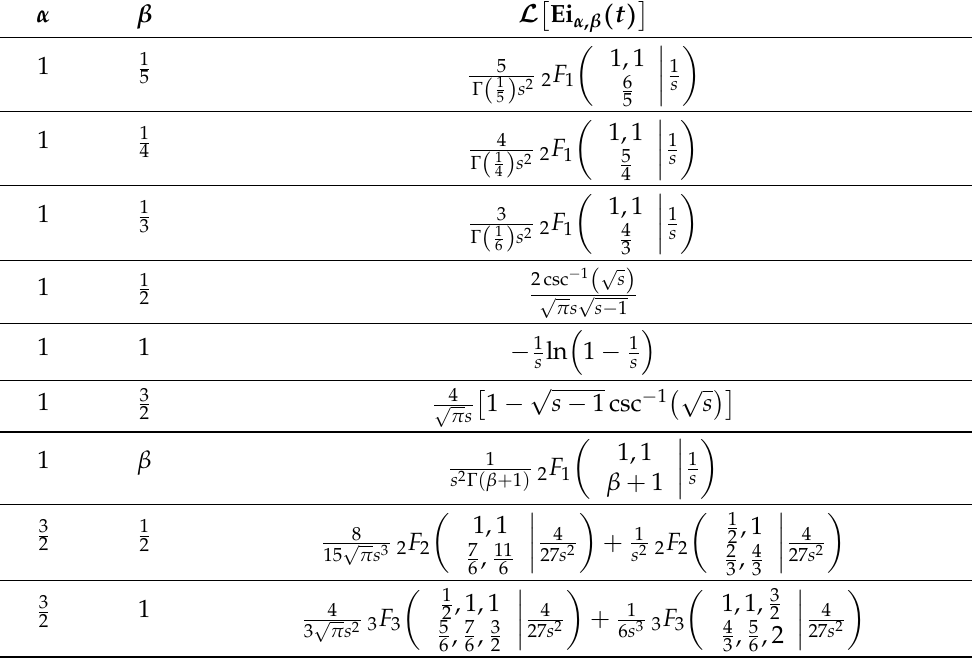
Figure 2. The integral two-parameter Mittag-Leffler function Ei 1, β ( x ) as a function of variable x and parameters β . Table 3. The Laplace transforms of the integral Mittag-Leffler functions Ei α , β derived for some values of parameters α and β by using